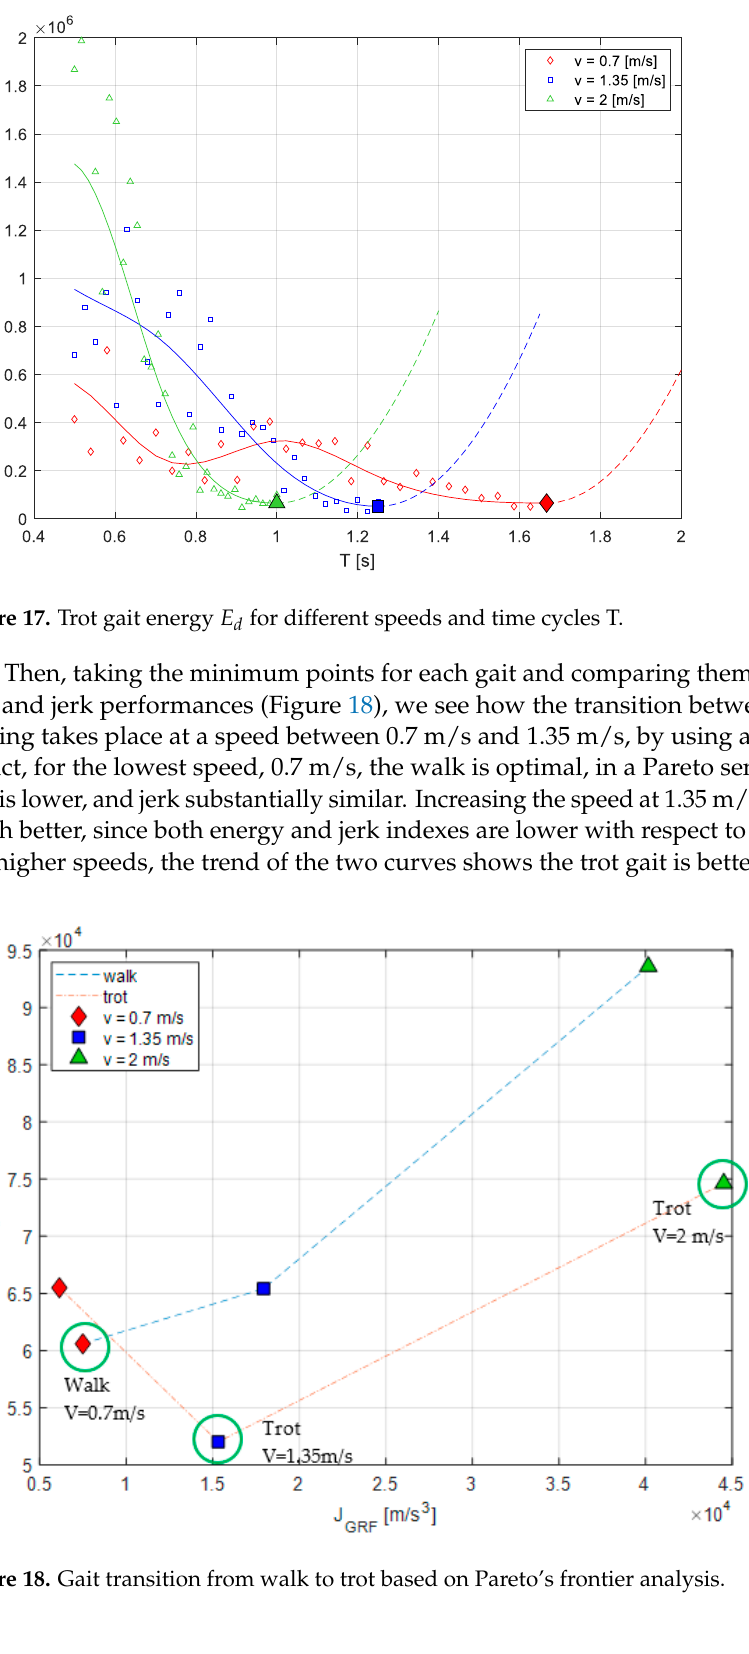
Figure 18. Gait transition from walk to trot based on Pareto’s frontier analysis.